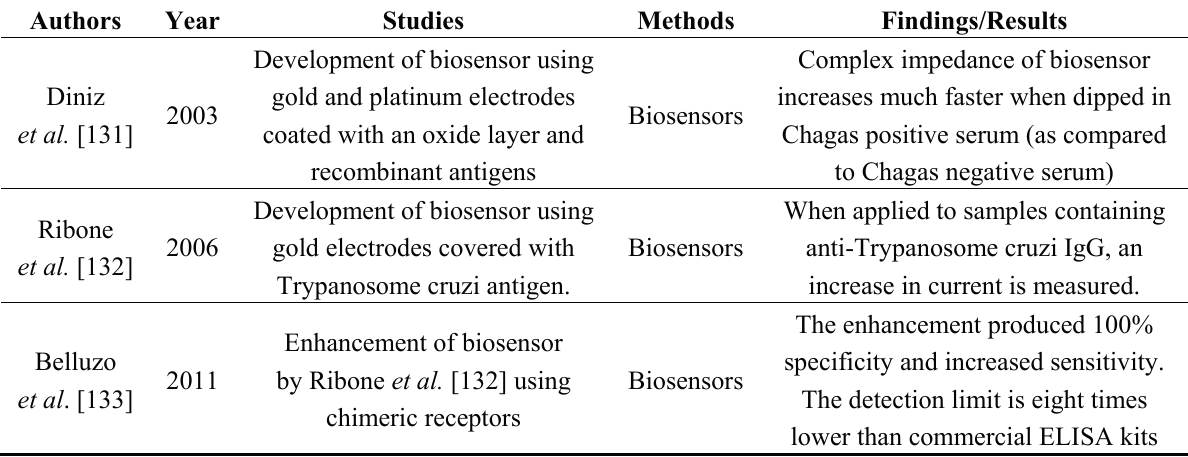
Table 12. Summary of biomedical engineering techniques in Chagas